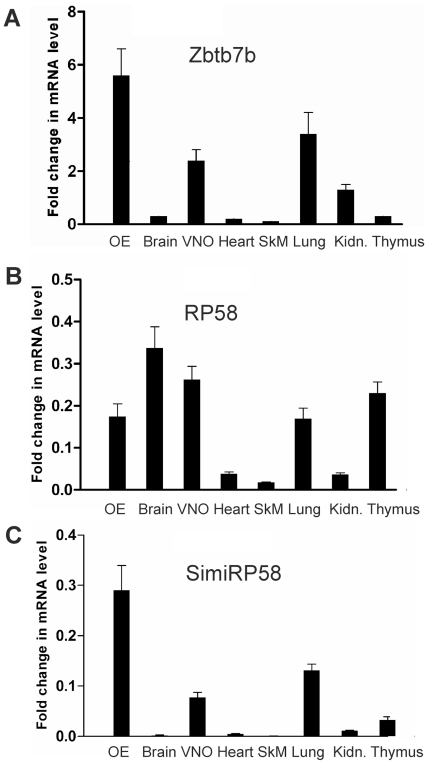
Relative gene expression levels of Zbtb7b, RP58 and simiRP58 across different mouse tissues.Quantitative RT-PCR was performed in triplicate using primers specific for Zbtb7b, RP58, simiRP58 and GAPDH with cDNAs prepared from mouse olfactory epithelium (OE), brain, vomeronasal organ (VNO), heart, skeletal muscle (SkM), lung, kidney and thymus. The levels of Zbtb7b, Rp58 and simiRP58 mRNAs detected in each tissue were normalized to GAPDH and are shown relative to the expression levels in testis.